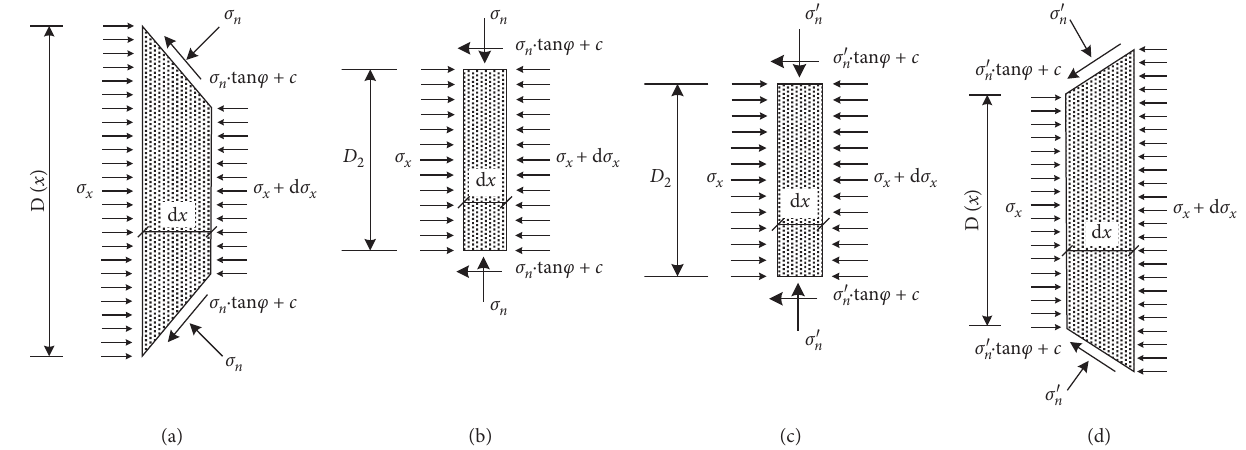
Figure 14: Small element of plastically deforming soil. (a) BB ′ E ′ E zone. (b) EE ′ A ′ A zone. (c) EE ′ A ′ A zone. (d) DD ′ G ′ G